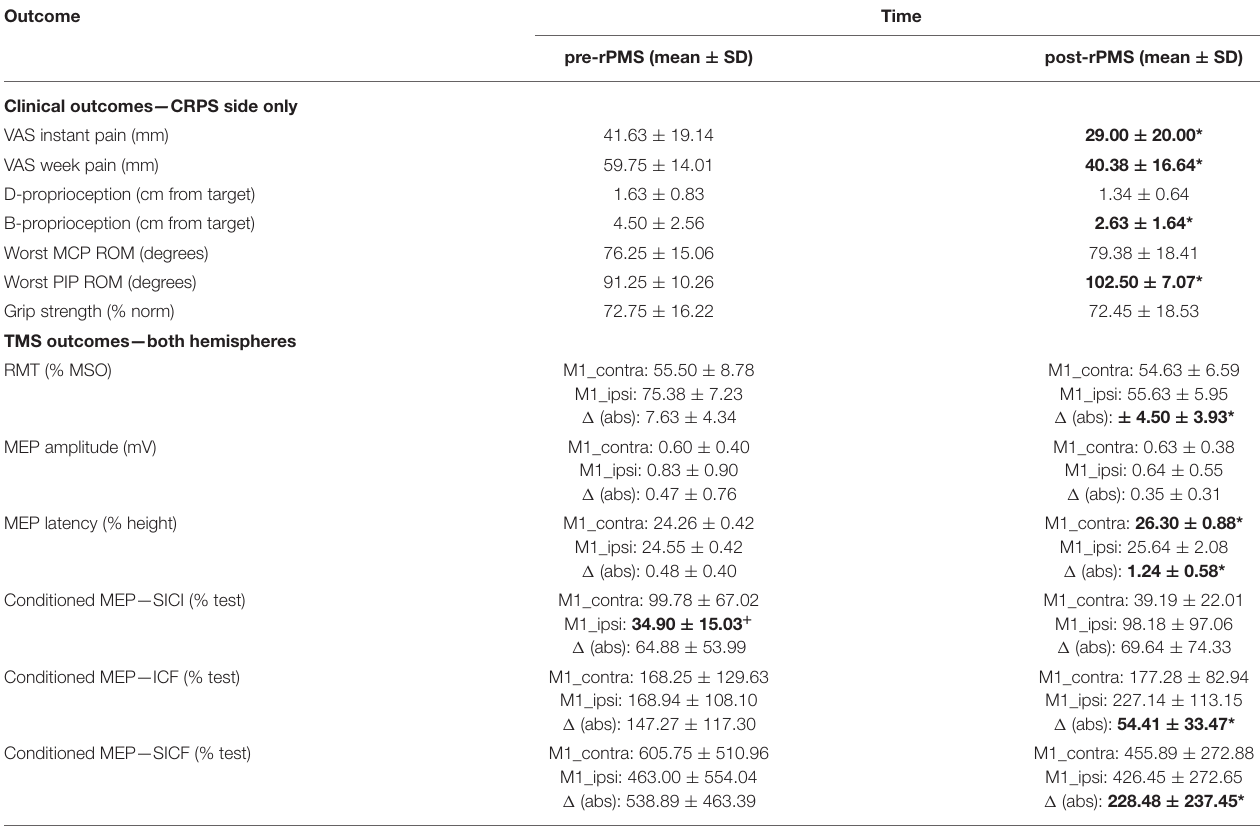
TABLE 2 | Clinical and TMS data of participants.